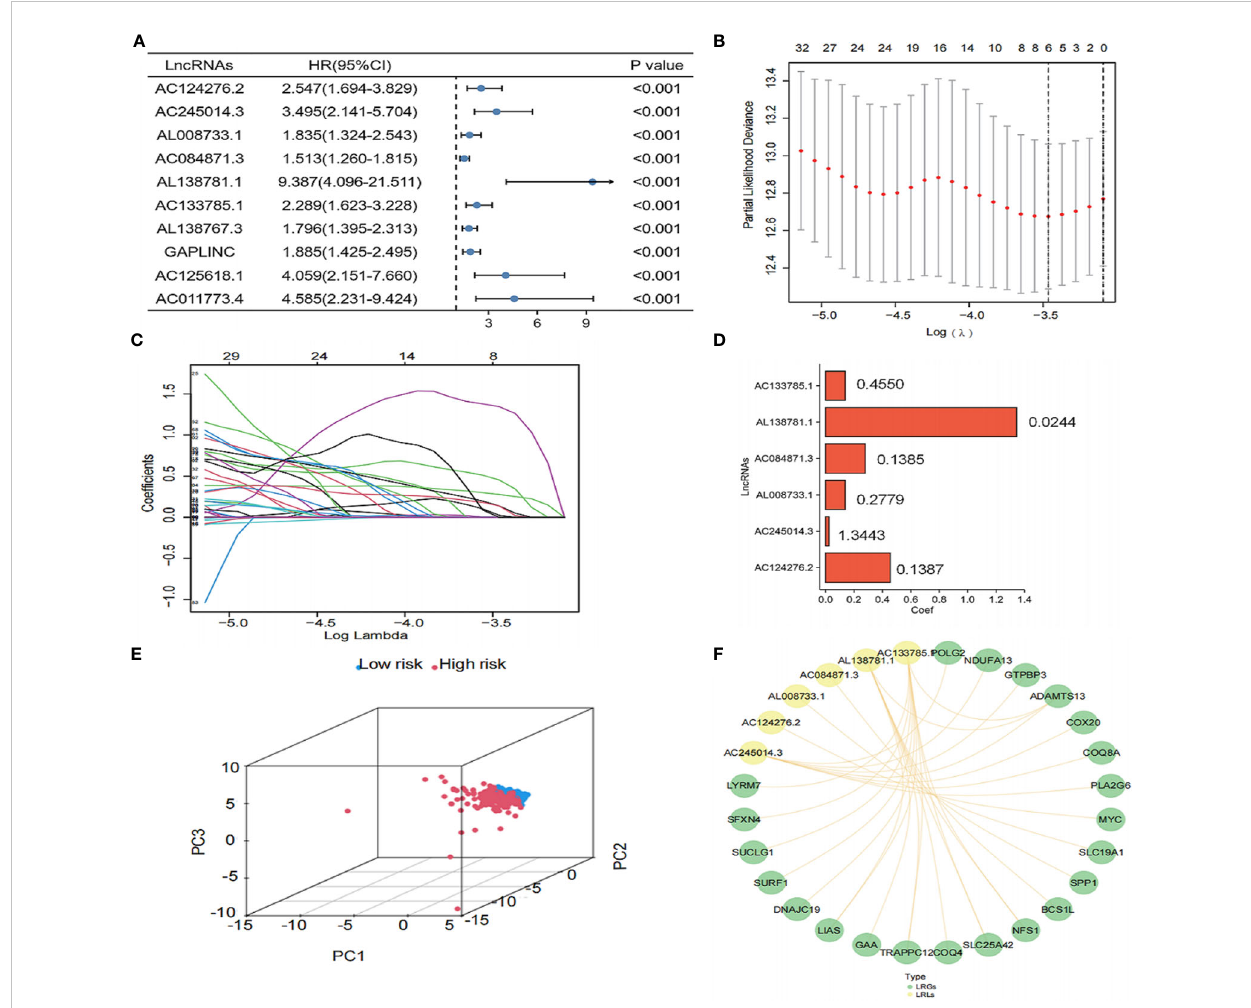
FIGURE 4 Construction of the risk model. (A) Univariate Cox analysis of the differential LRLs. (B, C) LRLs with HR<1 and P<0.05 in Cox analysis were selected from the criteria to construct the best predictive signature, and the risk score of the THCA cohort was calculated using the coef fi cients obtained by the Lasso algorithm. (D) Visualization of the coef value. (E) A total of 1,118 LRLs in the high- and low-risk groups were identi fi ed. (F) Visualization of the LRGs and six LRLs of the constructed model (correlation coef fi cient>0.4, P<0.05). P<0.05 was considered signi fi